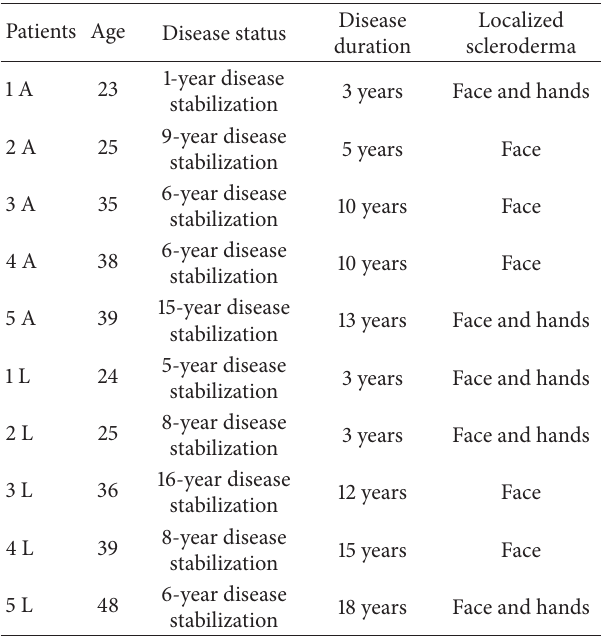
Table 1: Patients’ characteristics: A: patients treated with ADSCs injection and L: patients treated with fat